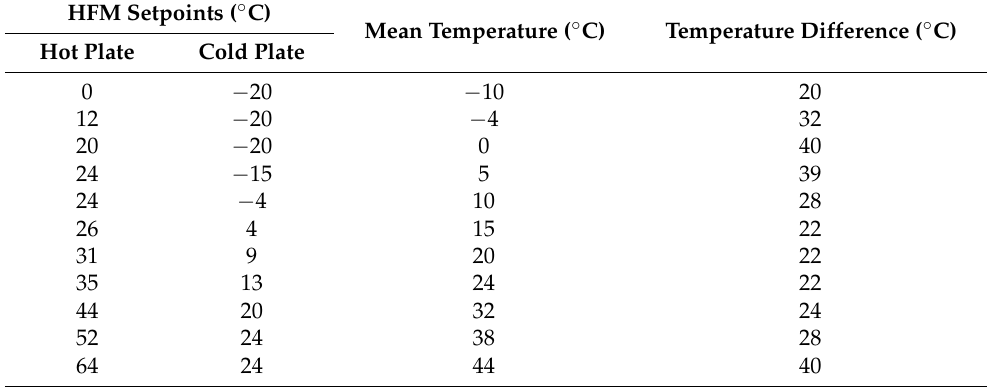
Table 2. HFM hot and cold plate setpoints and mean